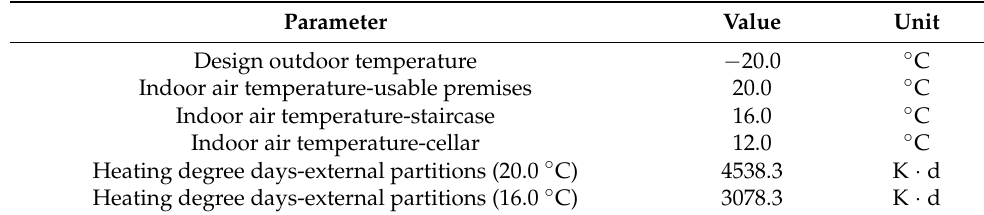
Table 1. Design thermal conditions for the considered location.